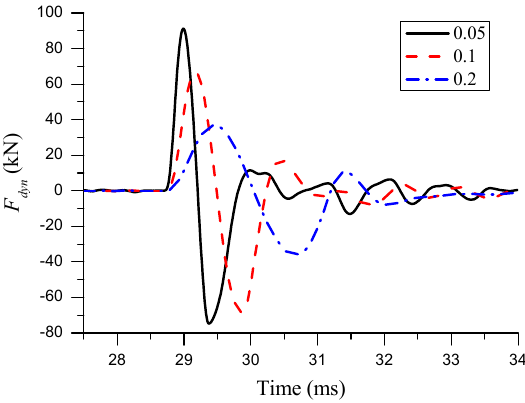
Figure 13. The response of wheel–track force under excitation of welds with different wavelengths.